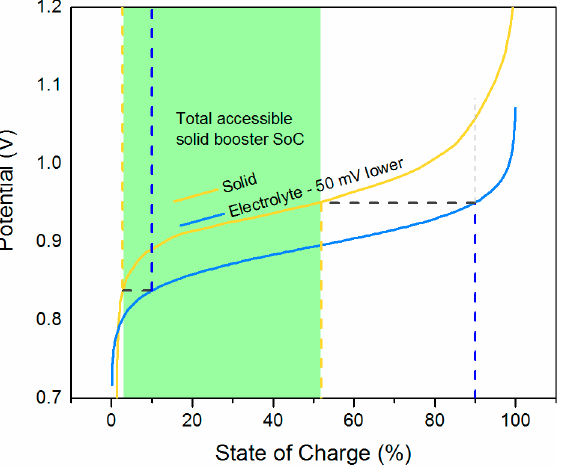
Figure 4. Accessible SoC of solid booster as a function of electrolyte potential. 𝐸 (cid:2869)(cid:2868) is 50 mV lower than 𝐸 (cid:2870)(cid:2868) .